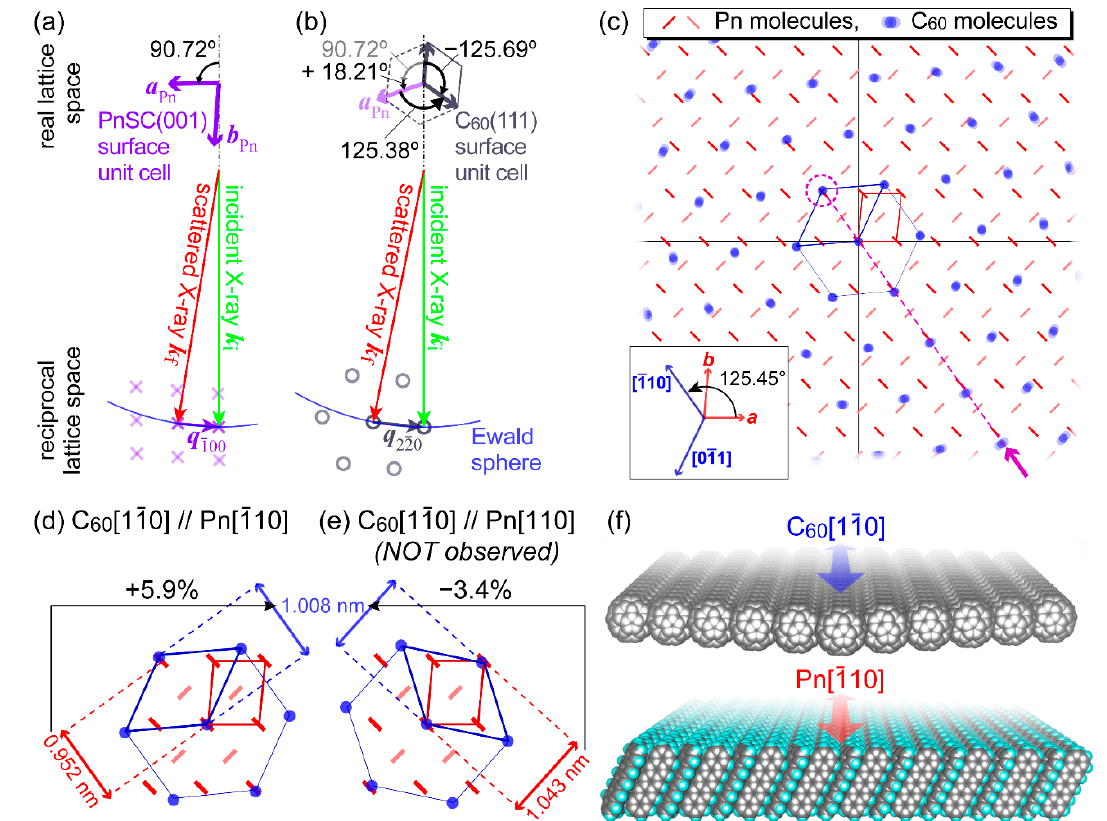
Figure 5. ( a ) In-plane orientation of the real space and reciprocal space lattices of the PnSC ( 001 ) surface at which the PnSC 100 diffraction condition is fulfilled. Cross marks indicate the reciprocal lattice points of the PnSC ( 001 ) surface. ( b ) In-plane orientation of the real space and reciprocal space lattices of the C 60 (111) surface at which the C 60 220 diffraction condition is fulfilled. The a -axis direction of PnSC at this orientation is also displayed for reference. Circles indicate the reciprocal lattice points of the PnSC (001) surface. ( c ) A schematic diagram representing an inter- lattice relationship between the PnSC (001) surface and the hetero-epitaxial C 60 overlayer. ( d ) Lattice mismatch between the C 60 (111) and PnSC (001) surfaces for the present inter-lattice orientation. ( e ) Lattice mismatch between the C 60 (111) and PnSC (001) surfaces for a hypothetical inter-lattice orientation where C 60 [110 aligns with the [64] direction of the PnSC. ( f ) Schematic illustration of the molecular arrangements of the contacting layers at the C 60 /PnSC